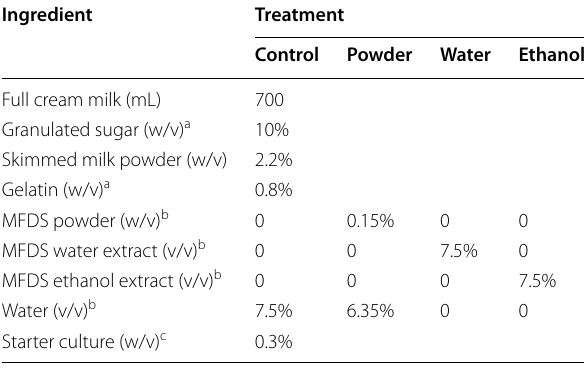
Table 1 Monascus -fermented durian seed yogurt